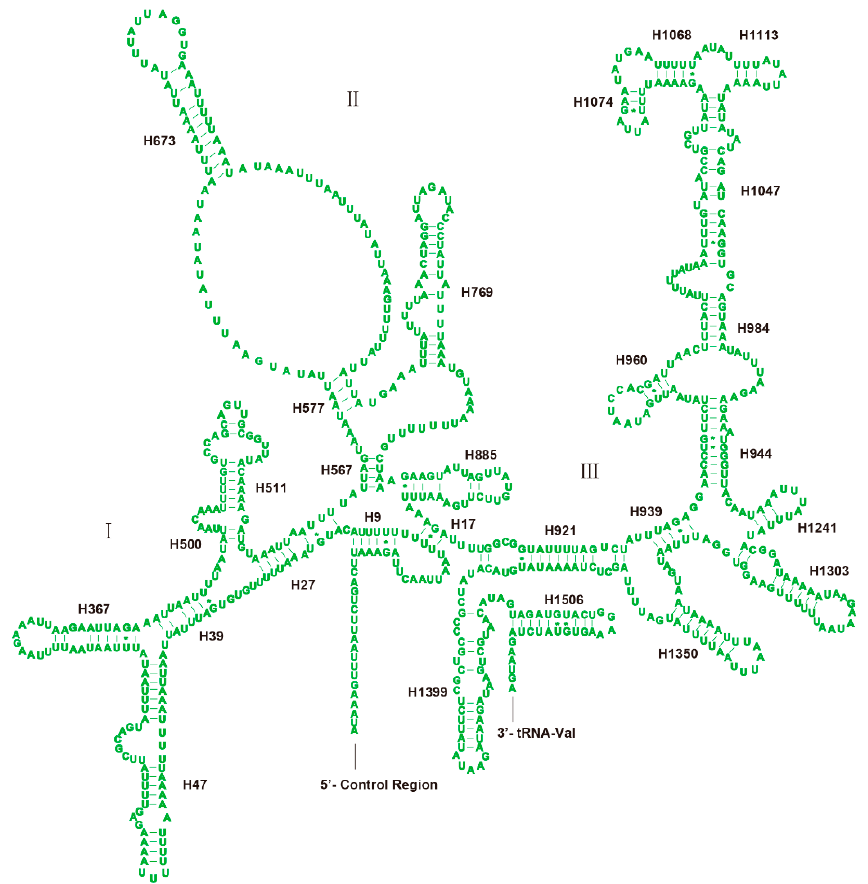
Figure 6. Predicted secondary structure of the mitochondrial rrnS in H. sinicus . The annotation is the same as for Figure 4.